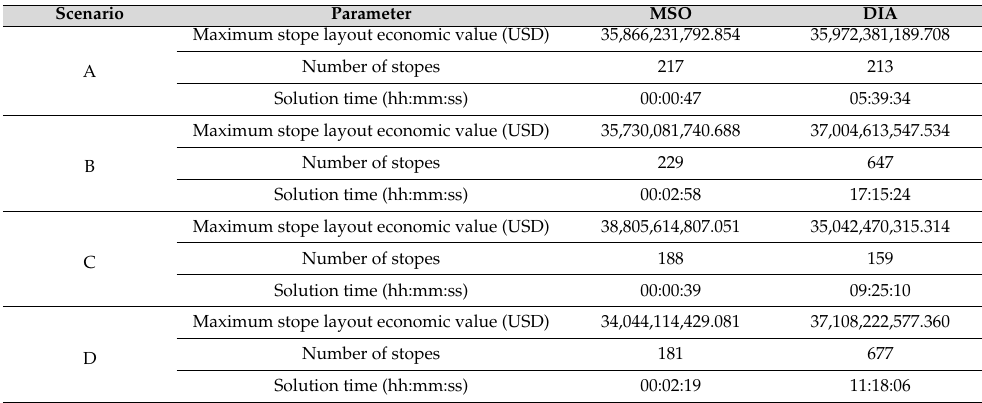
Figure 8. Comparison of the performance of the DIA and MSO. Source: [3]. Table 5. Comparison of the optimum solutions generated by the MSO and DIA. Source: Adapted from [3].